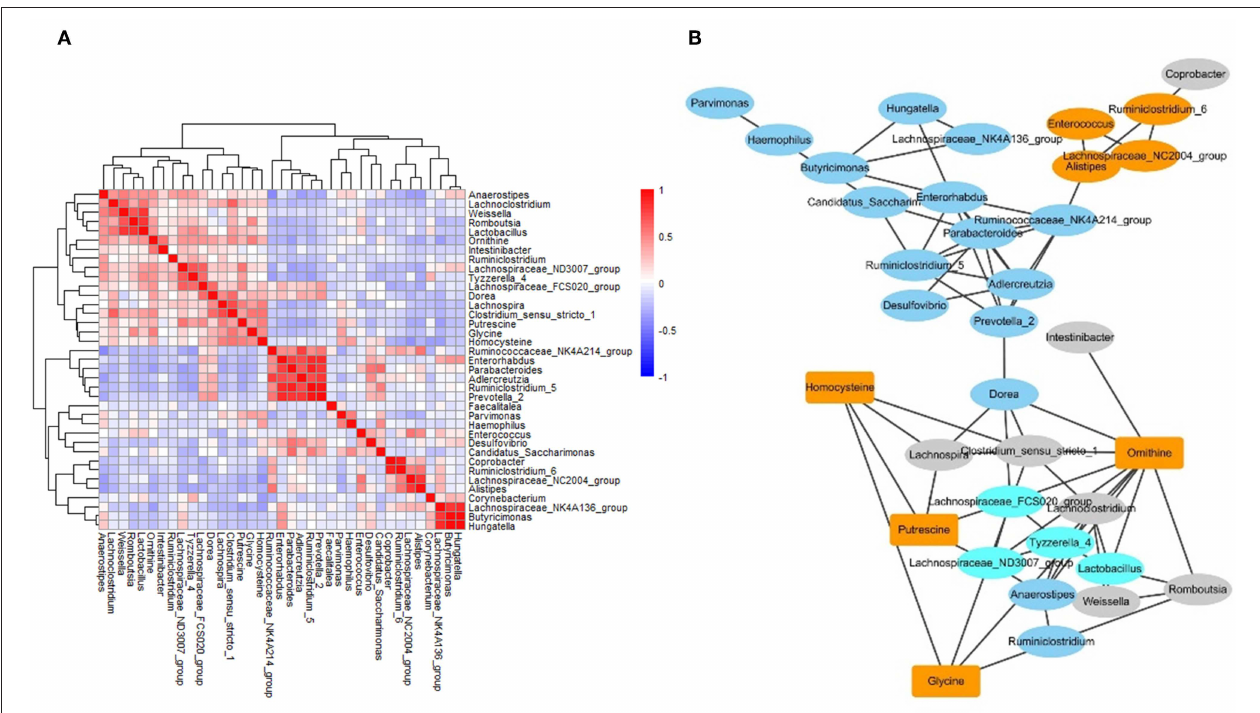
FIGURE 5 | The networks of gut microbiome and metabolites in IBS patients. (A) The correlation matrices between microbial genus abundances and fecal metabolites. (B) A network generated by Cytoscape. Each node represented a metabolite/microbe. Ellipse node represent microbe, and rectangle node represent metabolite. Different color reflected different cluster by WGCNA. The edge linked the nodes reflected the Pearson correlation coefficient between those nodes. Higher coefficients were displayed with thicker lines.